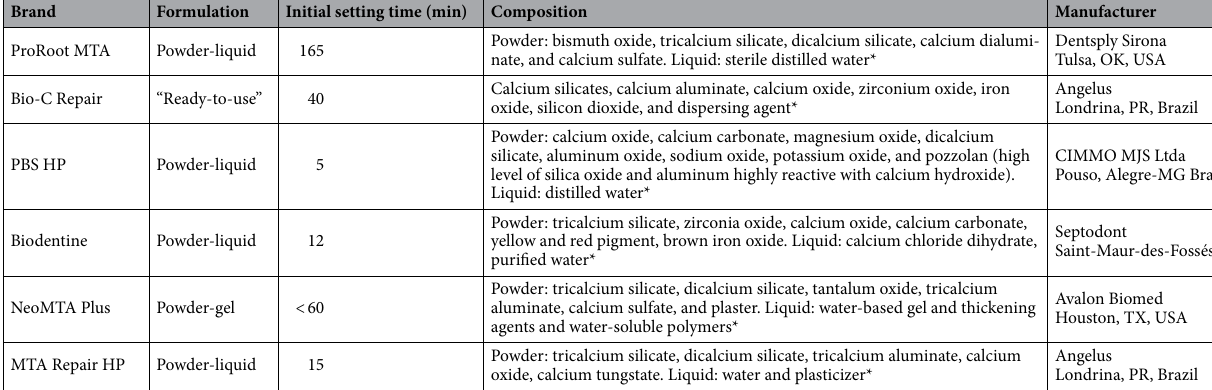
Table 1. Endodontic cement specifications. *Manufacturer